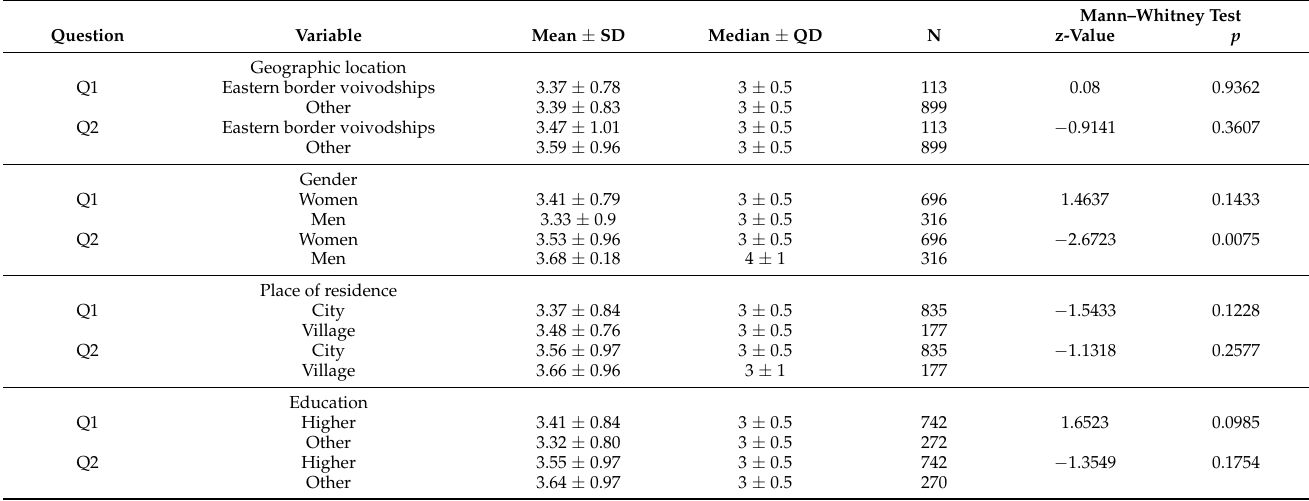
Table 6. Comparison of the answer of the given question (Q1, Q2) with geographic location, gender, place of residence, and education.